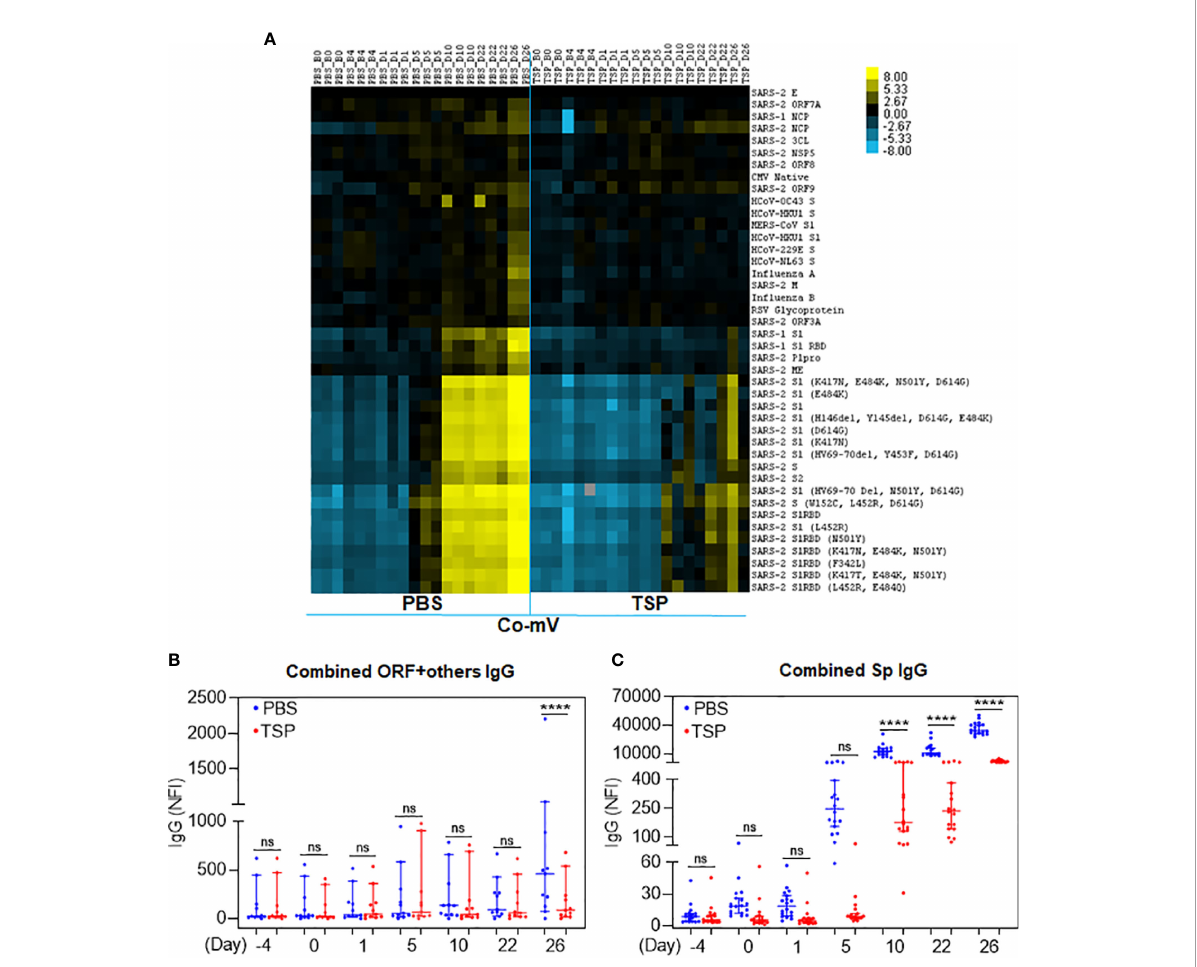
FIGURE 6 TSP drug combination attenuated the Co-mV- production of IgG antibodies against SARS-CoV-2 viral antigens in Balb/C mice. IgG antibody pro fi le to SARS-CoV-2 viral antigens in the PBS vehicle treated and TSP drug combination treated Balb/C mice that were immunized with P fi zer Co-mV, as indicated in materials and methods. (A) The heatmap shows IgG reactivity expressed in terms of row z-score for a respective antigen across different mice samples. Each antigen was organized into rows with serum specimens organized into columns classi fi ed as B0, B4, D1, D5, D10, D22, and D26 (similar to that detailed in Figure 5). Reactivity was represented by color (Light Blue=low, Black=mid, Yellow=high) and the heatmap represents NFI as detailed in Figure 5. (B) Analysis of heatmap data illustrating the sum of IgG NFI responses for combination of SARS- CoV-2 antigens representing different domains devoid of spike as detailed in panel (B) of Figure 5. (C) Analysis of the heatmap data revealing the sum of IgG NFI responses for combination of different SARS-CoV-2 spike antigens such as SARS-CoV-2 S1, S2, and RBD subunits. In panels (B, C) , PBS and TSP treated samples were represented in blue and red dots, respectively. Data was expressed as median ± 95% CI and the statistical inferences was derived using nested one-way ANOVA with Sidak ’ s multiple comparison post-hoc analysis (**** p < 0.0001, ns – not signi fi cant, as indicated). Co-mV, COVID-19 mRNA vaccine; PBS, phosphate buffered saline; TSP, tacrolimus-sirolimus-prednisone combination; IgG, immunoglobulin G; NFI, normalized fl uorescence intensity; CI, con fi dence